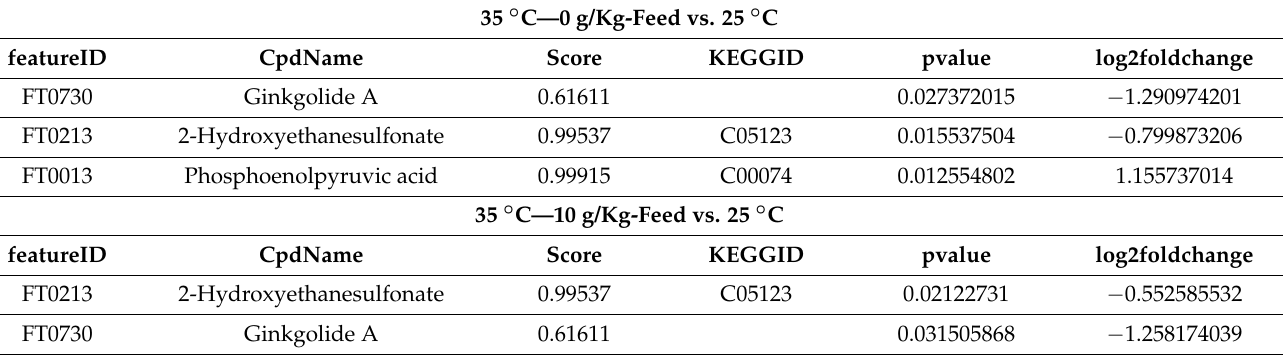
Table 2. Effect of the Nile Tilapia metabolites exchange. The brain of Nile tilapia is fed with acetyl- xylogalactan for 4 weeks under heat stress. The red mark denotes downregulation compared to the 25 ◦ C (control). The green mark was meant to up regulation compared to the 25 ◦ C